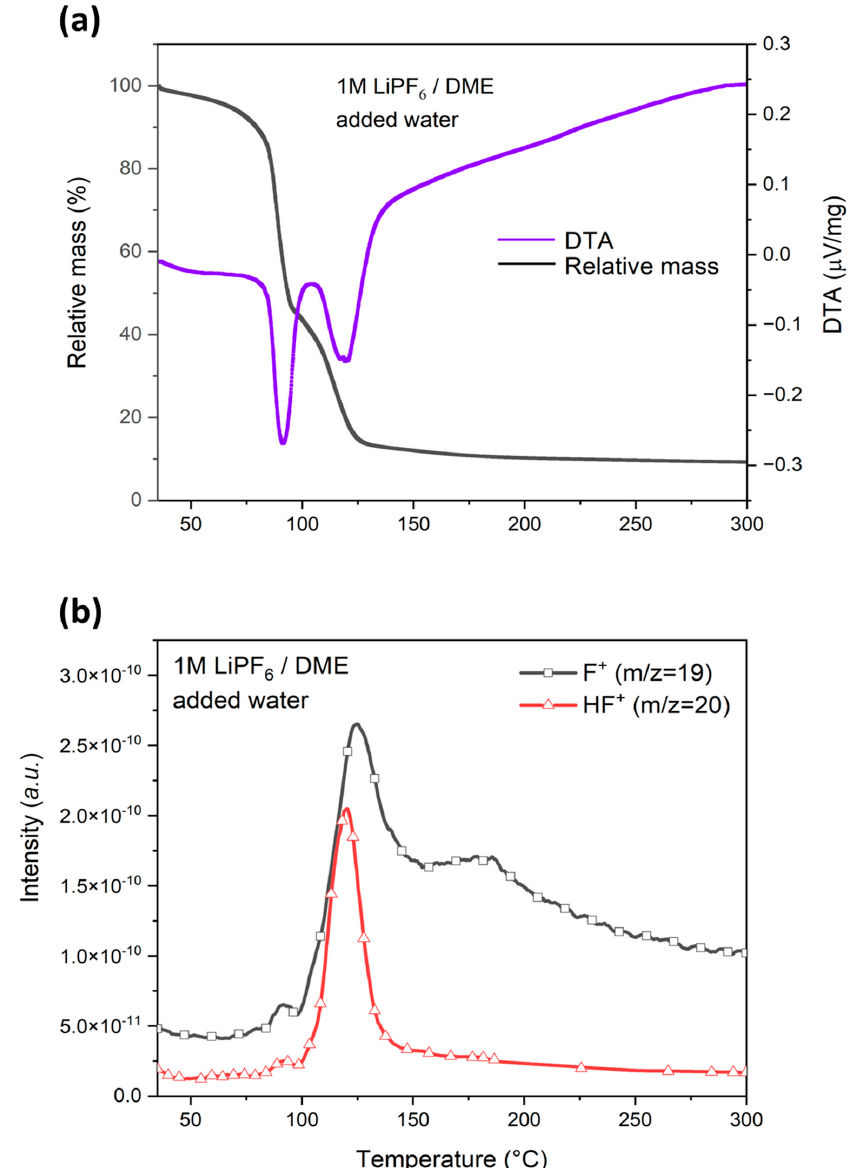
Figure 10. ( a ) TG/DTA curves of HF generation temperature in 1 M LiPF 6 /DME electrolyte solution with added water, and ( b ) the simultaneous F + and HF + identification using MS.